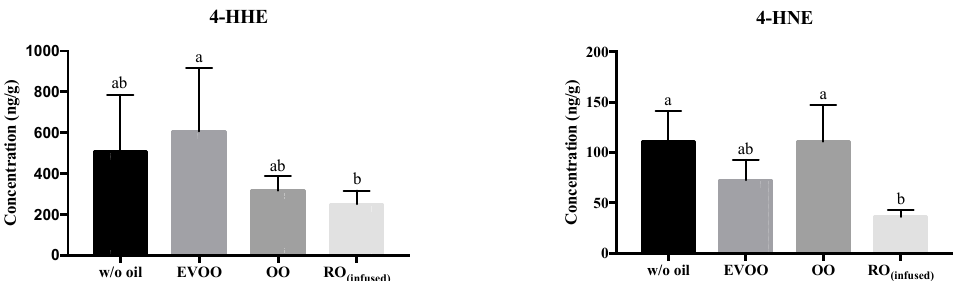
Figure 3. Level of 4-HHE and 4-HNE in pan-fried salmon (ng of analytes per g of salmon meat). Data presented are mean ± S.D. ( n = 6). w/o oil: without oil; EVOO: extra virgin olive oil; OO: olive oil; RO (infused) : rosemary-infused oil. Columns sharing different alphabets are significantly different at least p < 0.05.